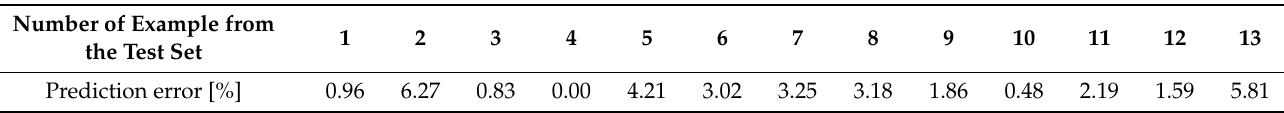
Table 1. Summary of the prediction errors of the developed neural model for the subsequent examples of the test set, determined for the average methane seam pressure (see Figure 3).